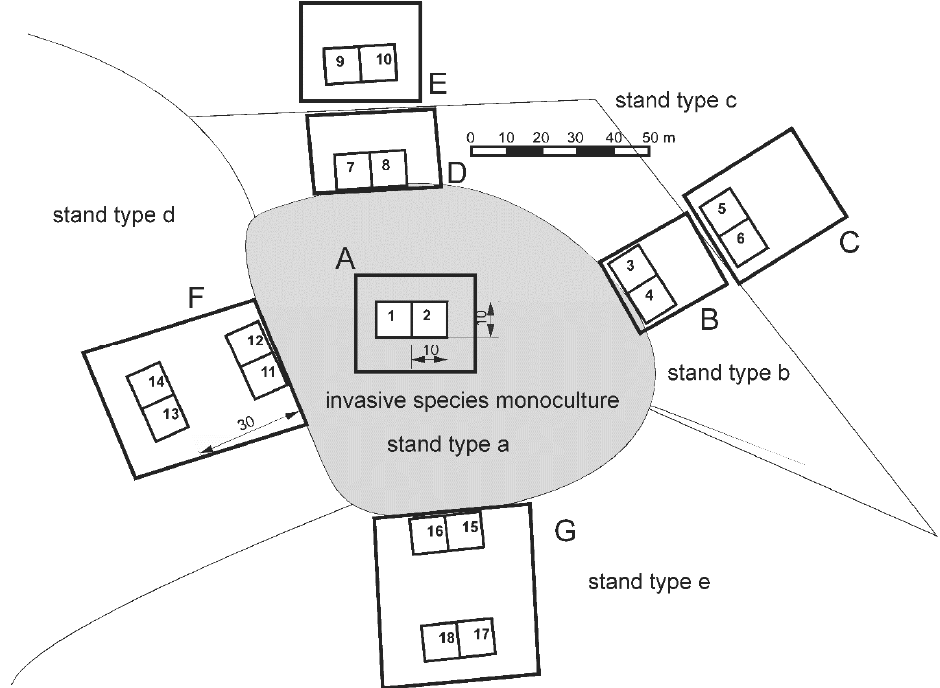
Figure 1. Study design: Scheme for a block of experimental plots in the field (each of the 21 blocks is a set of 18 square plots, measuring 100 m 2 each [43]). Tree stand structure plots (marked by capital letters) are used to describe homogenous tree stands. Vegetation plots (numbers 1–18) were used for light availability measurements.